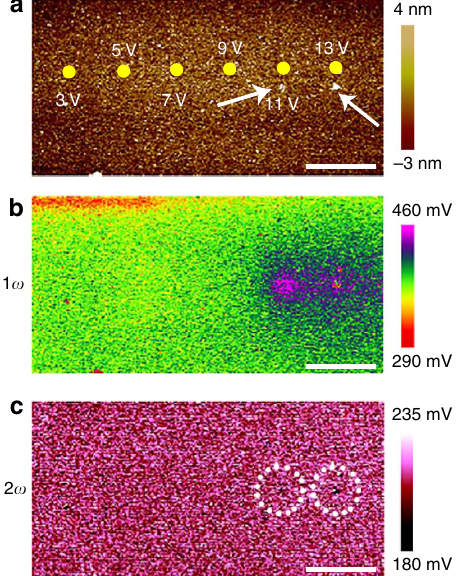
Figure 4 | Electrostatic force microscopy characterization on Al 2 O 3 with retardant oxygen ion migration. ( a – c ) Topographic ( a ), 1 o ( b ) and 2 o ( c ) measurements on the Al 2 O 3 /TiN sample after voltage sweepings to 3, 5, 7, 9, 11 and 13V at different locations. No charge accumulation was observed below 11V. Scale bar, 4 m m. The arrows and circles indicate regions where structural distortions to the Al 2 O 3 film were observed in the topographic profile and 2 o signal, respectively.